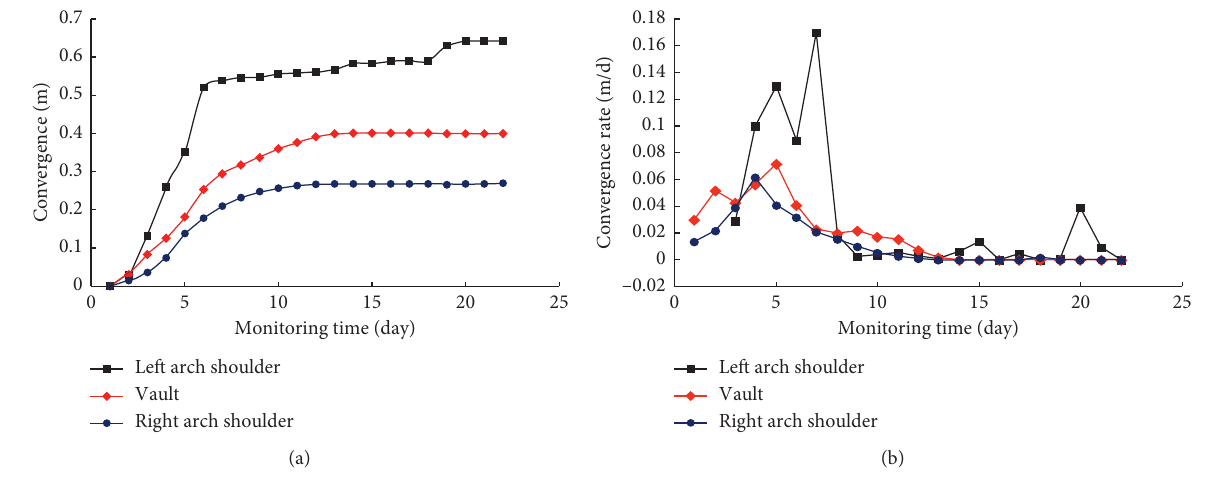
Figure 14: Monitoring curve. (a) K235 +477 convergence. (b) K235+477 convergence